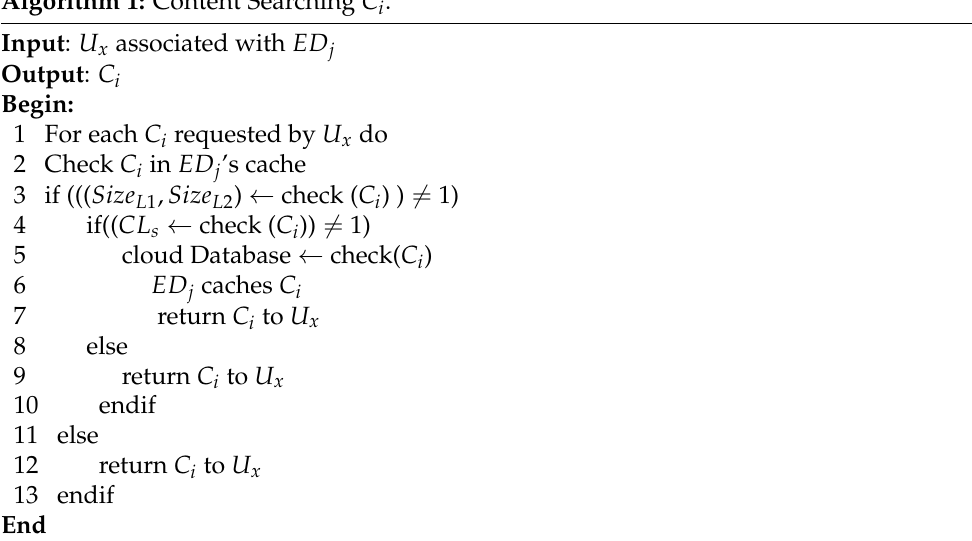
Algorithm 1: Content Searching C i